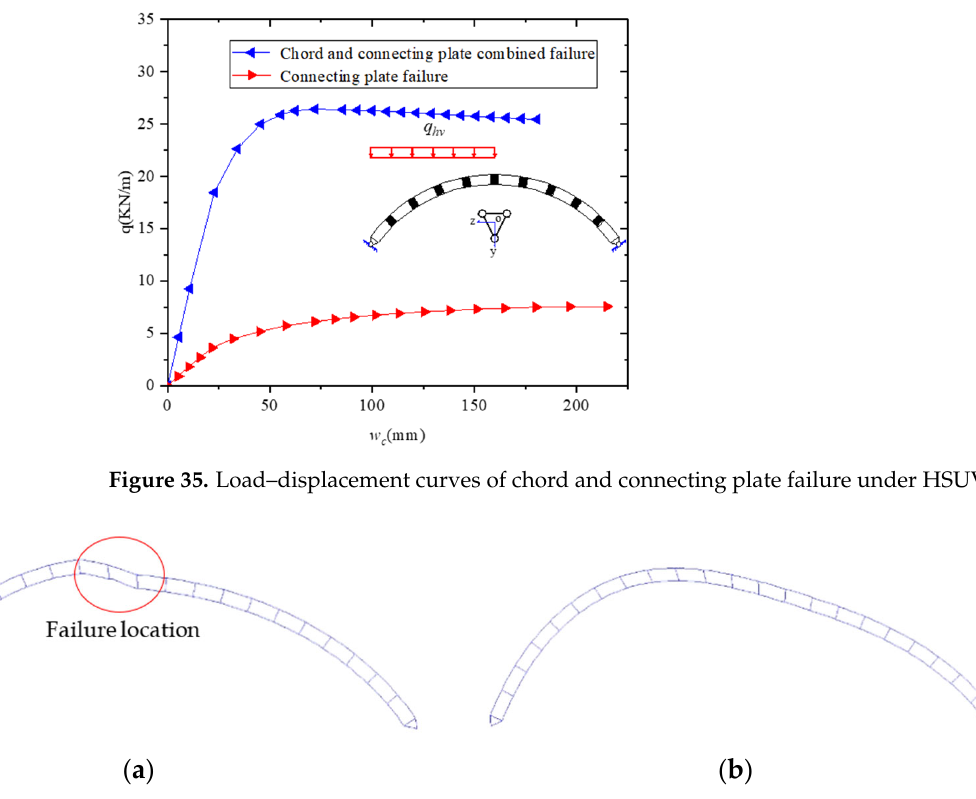
Figure 36. Global deformation and failure mode of the arch under HSUVL: ( a ) combined chord and connecting plate failure; ( b ) connecting plate failure.